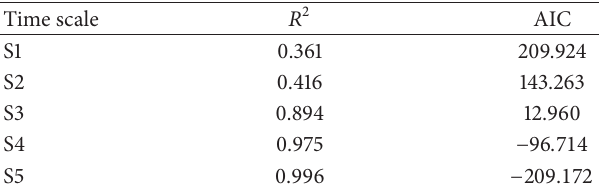
Table 3: 𝑅 2 and AIC for MLREs at different time